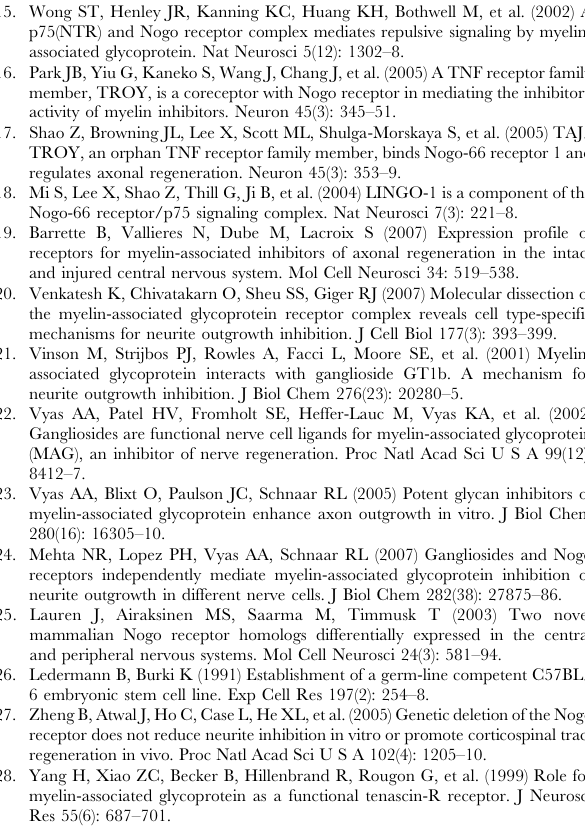
Figure S1 Activity of VCN on cultured sensory neurons. In order to address the specificity and effectiveness of VCN in our neuronal culture, we treated sensory neurons after plating with 5 mU/ml of VCN and (A) lysed the cells after approx. 20 hours. Immunoblotting of p75NTR, of which there are no reports about sialylation, demonstrates the absence of proteolytic side-effects of VCN. (B) Removal of sialic acid by VCN treatment increases binding of cholera toxin (CT) to mono-sialoganglioside GM1 as revealed by immunocytochemistry. The staining intensity of p75NTR is not affected by VCN treatment. Scale bar 40 m m. Figure S2 Glycosylation of wildtype MAG and MAG mutants. Wildtype and mutant MAG molecules which were expressed in CHO-K1 clonal lines are differentially glycosylated; importantly, the fully glycosylated form which, in wildtype MAG, migrates at approx. 100 kD, is present in the wildtype and in all mutants (arrow). Treatment of lysates with N-glycosidase F gives rise to